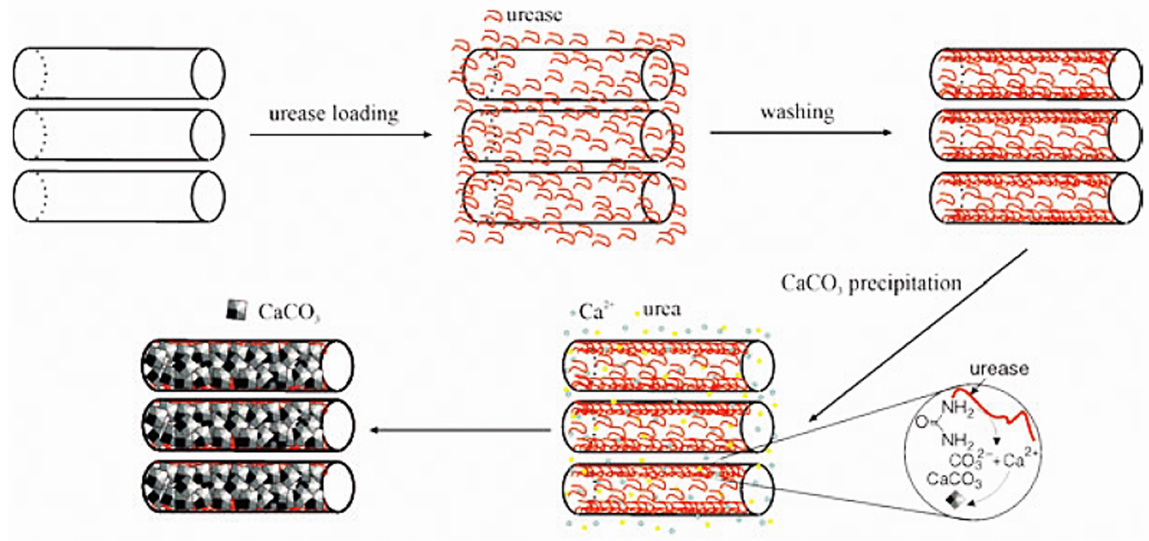
Figure 15: Schematic of the urease-catalyzed synthesis of CaCO 3 inside HNTs demonstrated by Shchukin et al. [28]